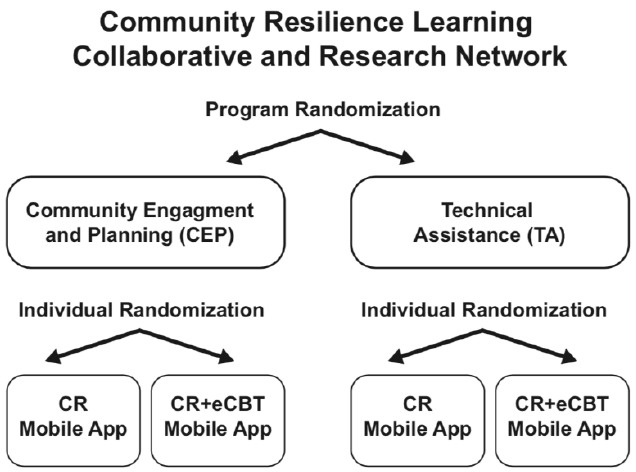
Figure 1. Community Resilience Learning Collaborative and Research Network Study Design.